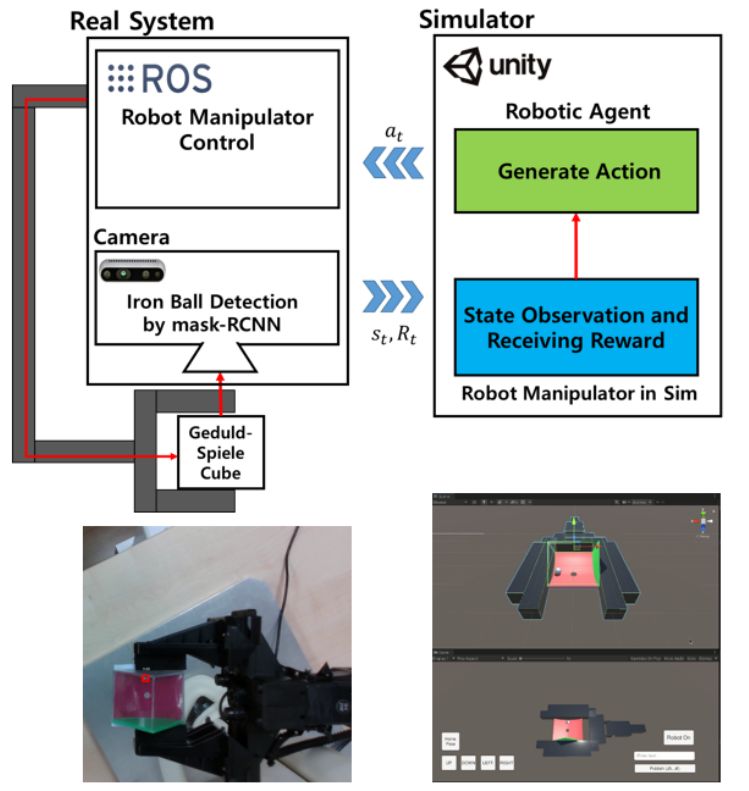
Figure 4. The proposed sim-to-real architecture: a real system diagram and camera view ( left ) and a simulator system diagram and virtual reality view ( right